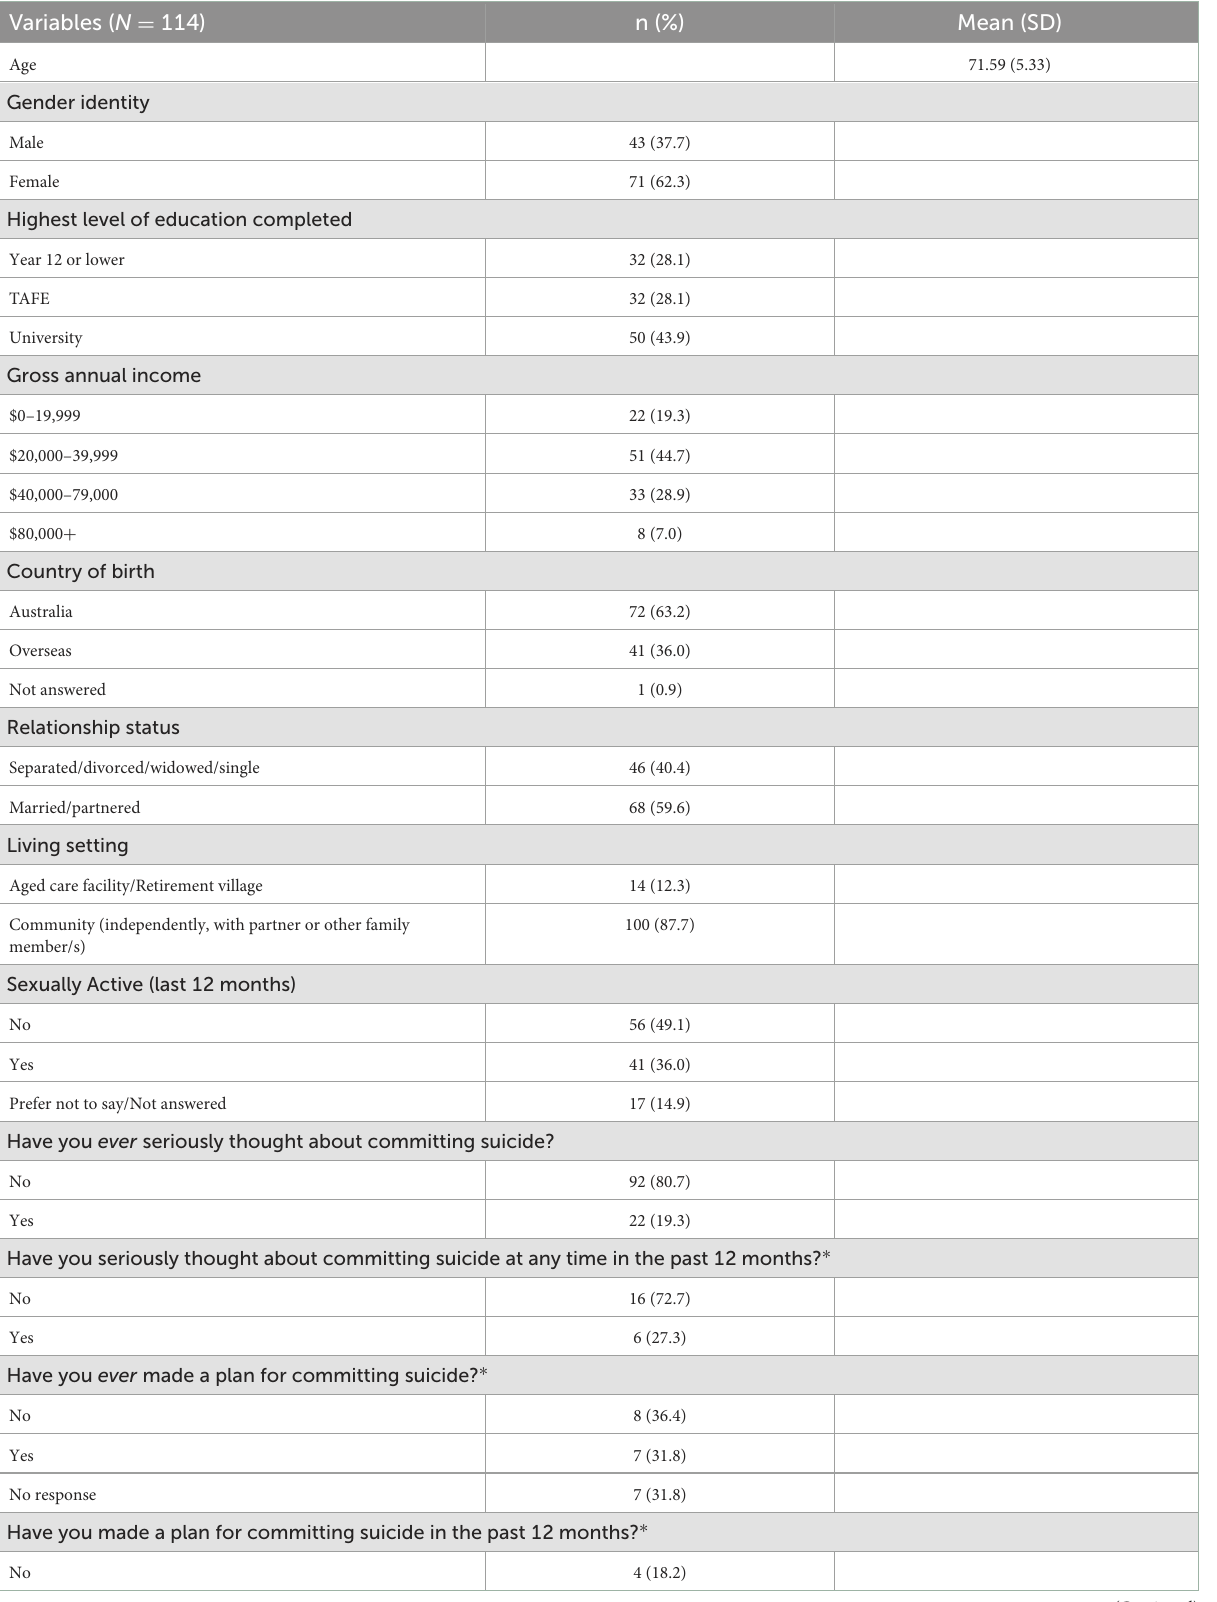
TABLE 1 Participant